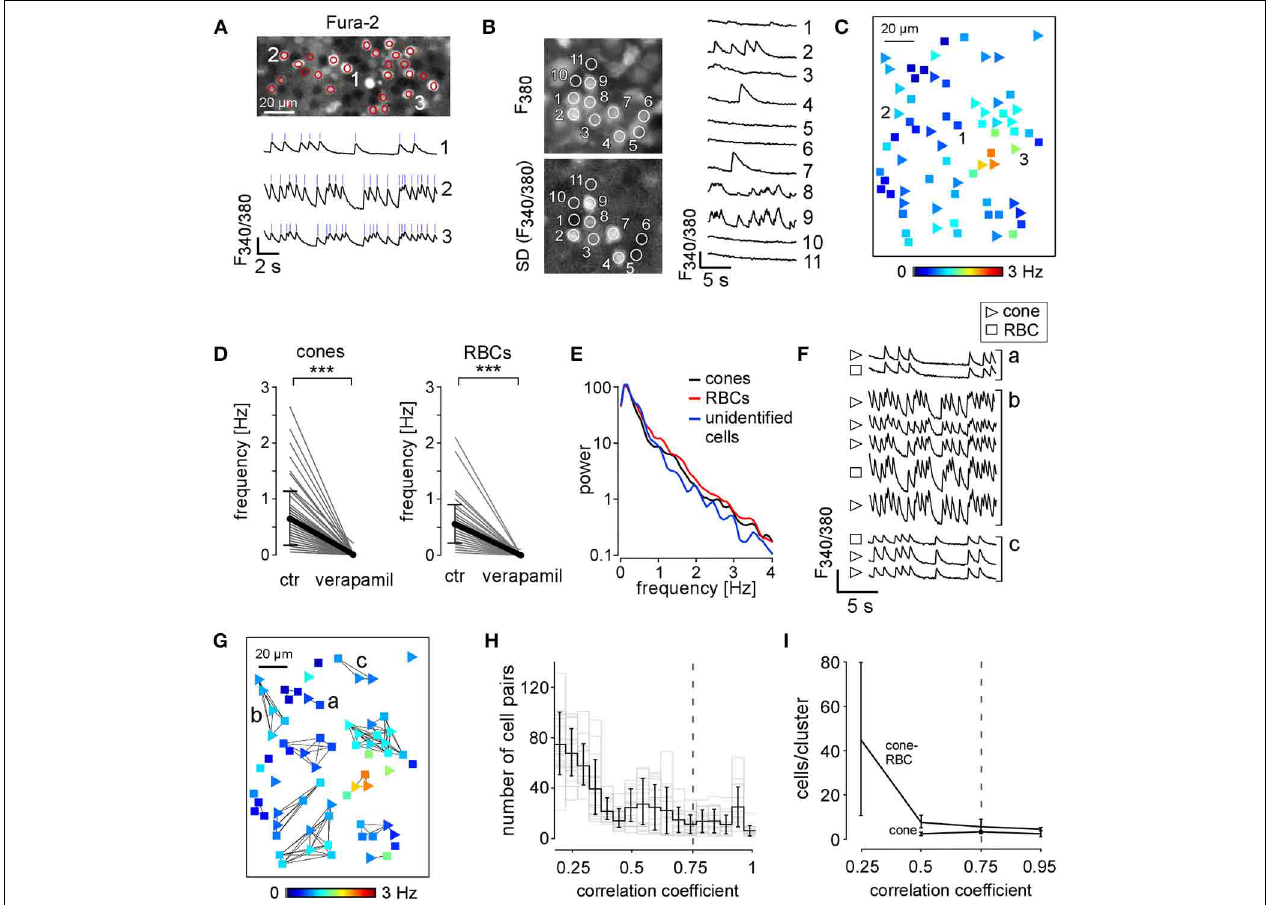
the activity in cones (black, n = 81), RBCs (red, n = 108), and unidentified cells (blue, n = 4); data from 3 experiments. (F) Exemplary Ca 2 + traces of cells exhibiting synchronous activity (clusters a-c in G ). (G) Activity map showing clusters with synchronous Ca 2 + transients (cross-correlation coefficient ≥ 0.75 indicated by lines). (H) Histogram showing the distribution of cross correlations between measured cell pairs ( n = 19 retinas) for different correlation coefficients. Gray dashed line indicates correlation coefficient ≥ 0.75 used for our analysis. (I) Plot showing cluster size (cells/cluster) of cone-only and cone-RBC clusters for different correlation coefficients. Cluster size did not vary for correlation coefficients ≥ 0.5. All error bars indicate